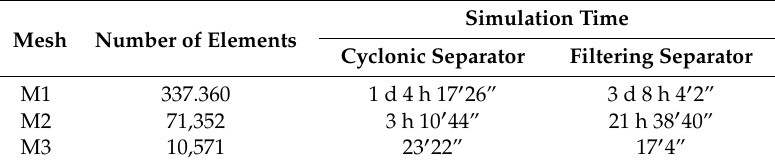
Table 4. Mesh information created for the convergence index analysis.